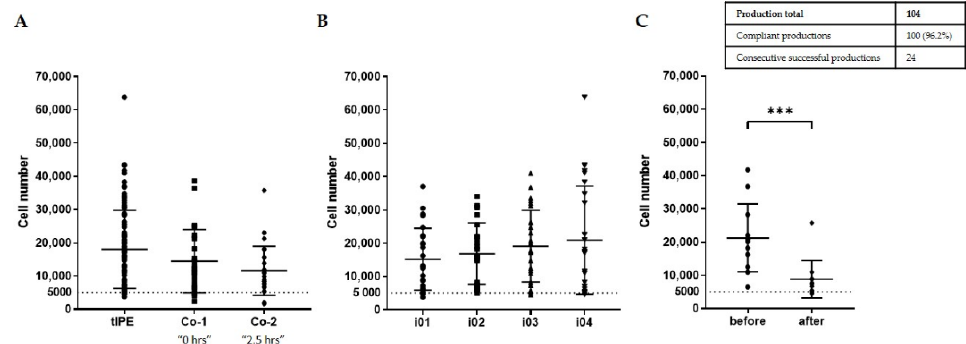
Figure 6. Number of cells isolated from one iris biposy. ( A ) The mean number of cells isolated in the clean room from all biopsies harvested for tIPE production was 17,882 ± 11,725. The number of cells isolated from the biopsies in the GMP ‐ grade LTTC by operators was not statistically different from the number of cells isolated from the biopsies in research conditions by the carrier ( p > 0.999). ( B ) The analysis of cell counts of the four iridectomies harvested per eye individually showed com ‐ parable cell numbers between the biopsy taken immediately after opening the eye (i01) and the last biopsy (i04) ( p > 0.999). ( C ) To quantify cell loss by centrifugation and verify that tIPE contained the conforming number of cells, the cell number was determined in 12 iris biopsies before and after centrifugation. Cell number after centrifugation was significantly lower than before centrifugation ( p = 0.0005, ***); however, the cell number was ≥ 5000 in 11 of 12 experiments. The dashed line marks the limit for product release. Cell viability. The mean “time from donor death to cell isolation” for the eyes available for the ValRun was 7.35 ± 1.29 d (range 2–8 d). We assume that this factor decreased cell viability compared to biopsies harvested from patients and thus, we did not define an absolute percentage of viable cells as specification in the ValRun but the difference in vi ‐ able cells in tIPE to control cells (Co ‐ 1 and Co ‐ 2) should not be significant. Since the con ‐ trols were not mixed with plasmid DNA, electroporated, or transported, a comparable percentage of viable cells in tIPE and controls excludes a negative impact of the produc ‐ tion procedure on cell viability. Figure 7 illustrates that the manipulations necessary for the manufacturing and transport of tIPE did not impact cell viability.